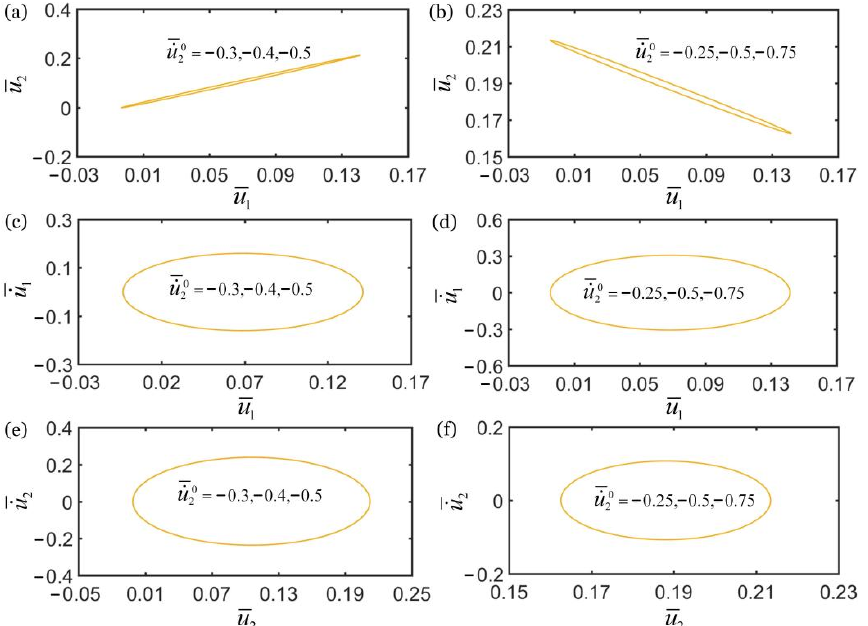
0 . u  on self-oscillations of the two coupled oscillators. ( a ) u 2 2 on self-oscillations of the two coupled oscillators. = k . ( b ) Domain of attraction, 2 = k . In the computation, the other geometric 2 0 . u  does not affect the self-oscil- u 2 2 does not affect the